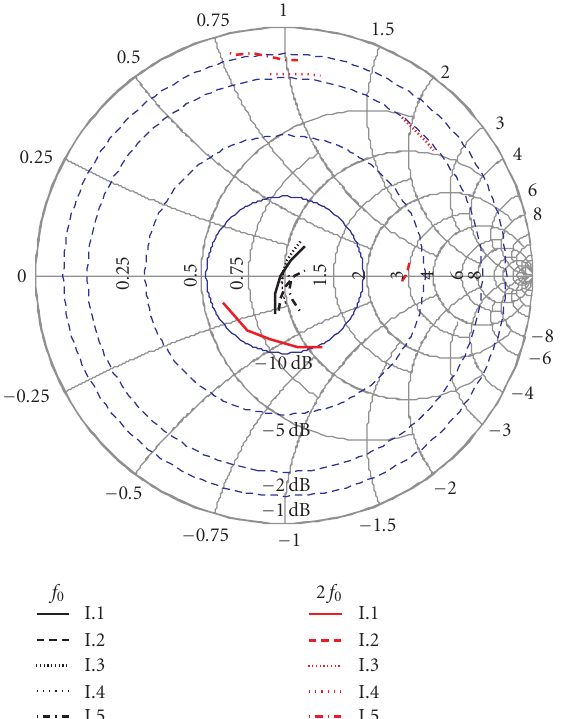
Figure 6: Input impedance over a 500MHz frequency band around f 0 and 2 f 0 for the DRA with a = 4 . 25mm (the geometrical configurations II.1 to II.5 are those listed in Table 2).